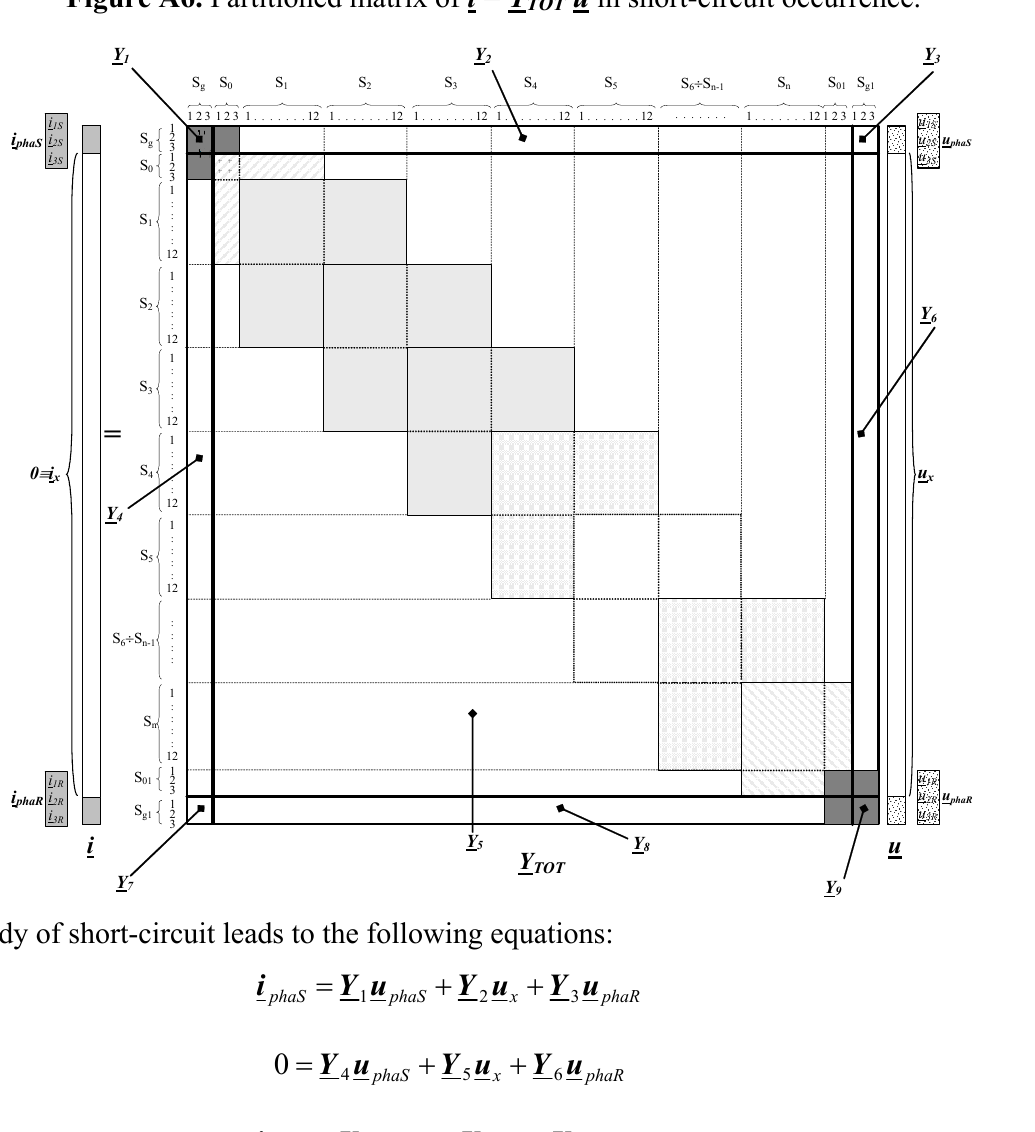
Figure A6. Partitioned matrix of i = Y